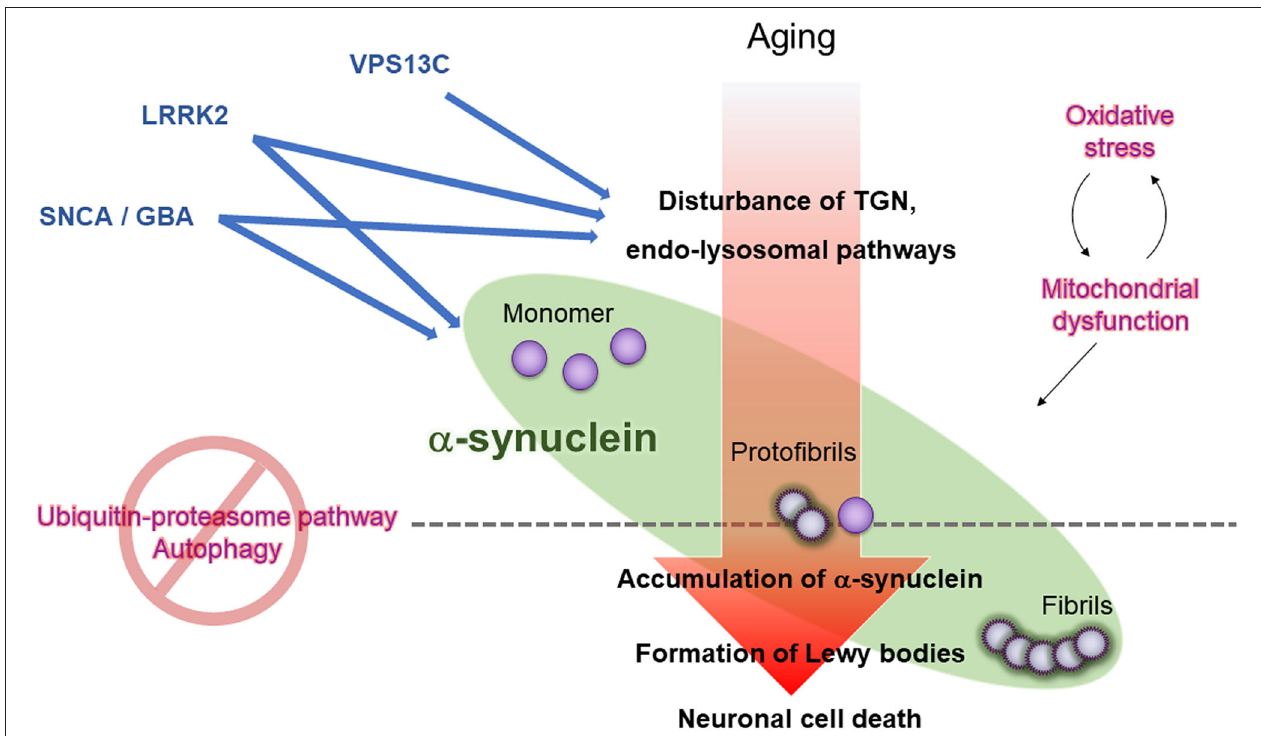
FIGURE 2 | Working hypothesis for LB formation and neuronal cell death in PD. Aging, oxidative stress, and mitochondrial dysfunction lead to dysregulation of the trans-Golgi network (TGN) and endo-lysosomes in neurons, ultimately impairing the removal of the precursor of pathogenic α -synuclein (protofibrils) through ubiquitin-proteasome pathway and autophagy, promoting LB formation, and propagating pathogenic α -synuclein to neighboring neurons. Mutations in PD causative genes and risk-related genes ( VPS13C , LRRK2 , SNCA , and GBA1 ) accelerate oxidative stress, mitochondrial dysfunction, and dysregulation of the TGN and